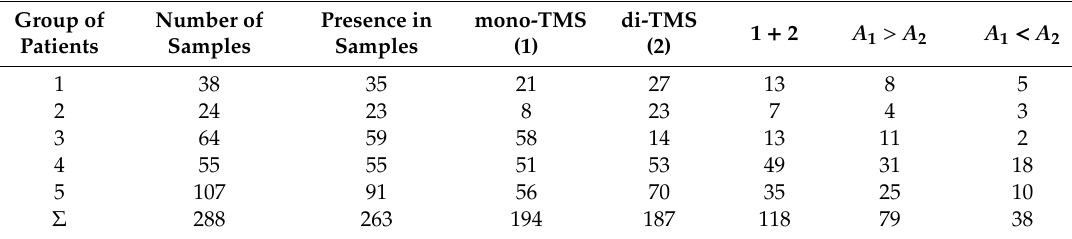
Table 2. Frequency of appearance of indole-3-acetic acid (3IAA) trimethylsilyl (TMS) derivatives in serum samples of critically ill patients using liquid–liquid extraction (LLE) as a sample preparation technique ( A –peak